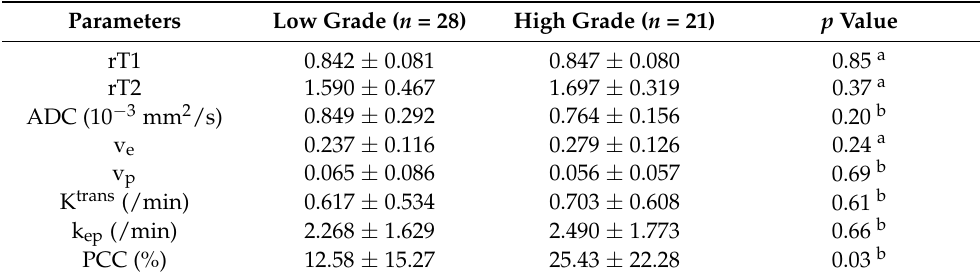
Table 4. MRI parameters and histologic percentage of collagen content of the low and high grade of Knosp classification.